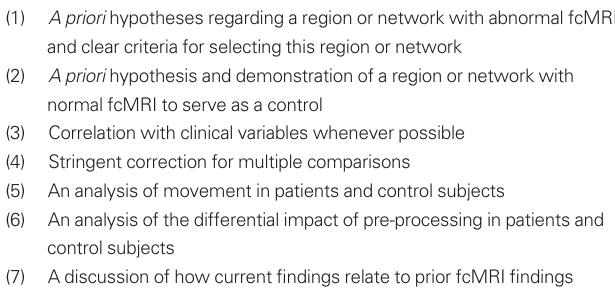
Table 2 | guidelines for studies of clinical populations with resting state